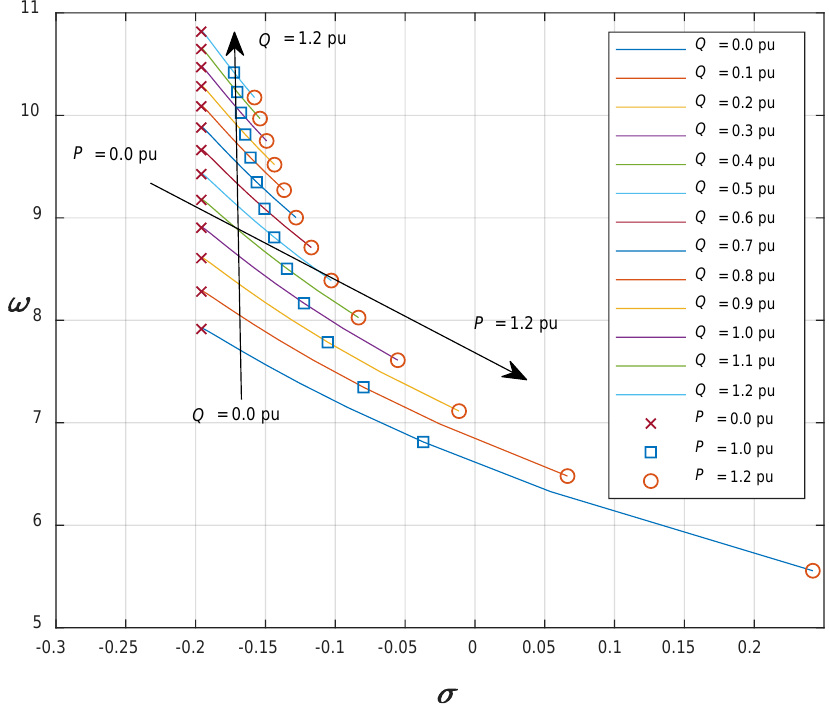
Figure 11. Eigenvalue loci of the local mode of 9-MVA hydro-type synchronous generator with AVR.